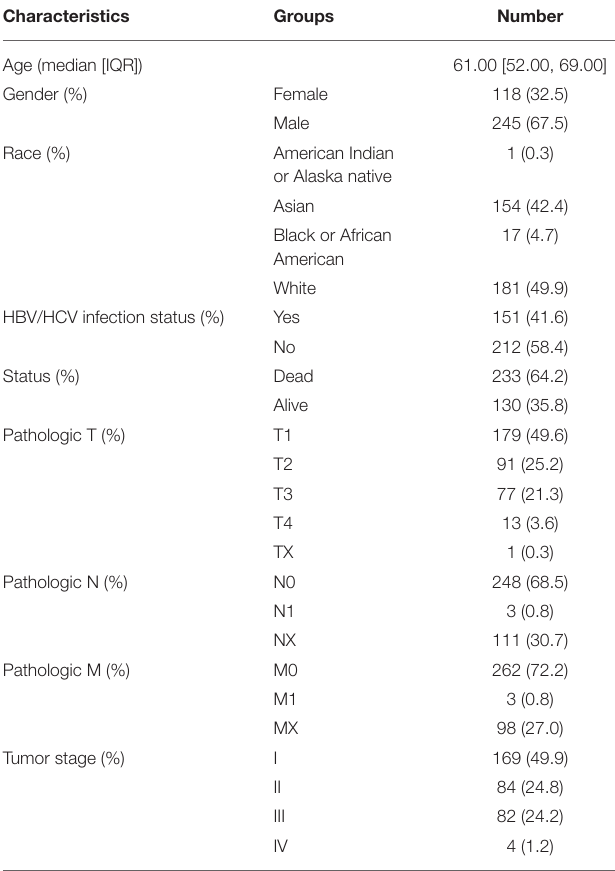
TABLE 1 | Clinical characteristic information for the LIHC cohort (overall =